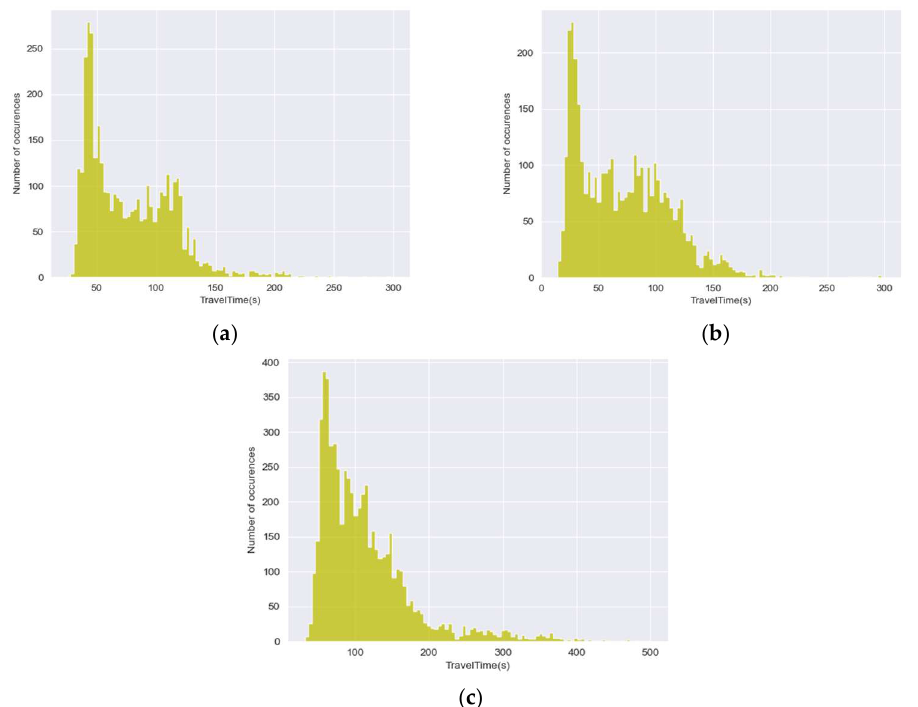
Figure 1. Frequency histograms of travel time distribution. ( a ) Road Link 1. ( b ) Road Link 2. ( c ) Road Link 3.